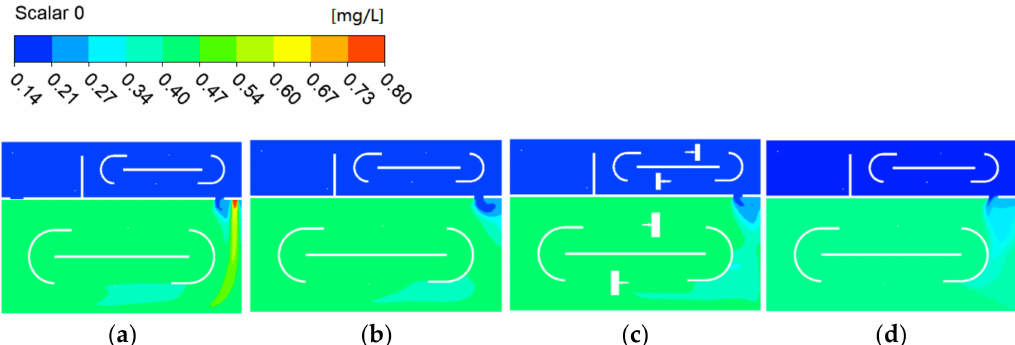
Figure 12. DO concentration contours of the biological selection pool, anaerobic pool, and anoxic pool at different heights.